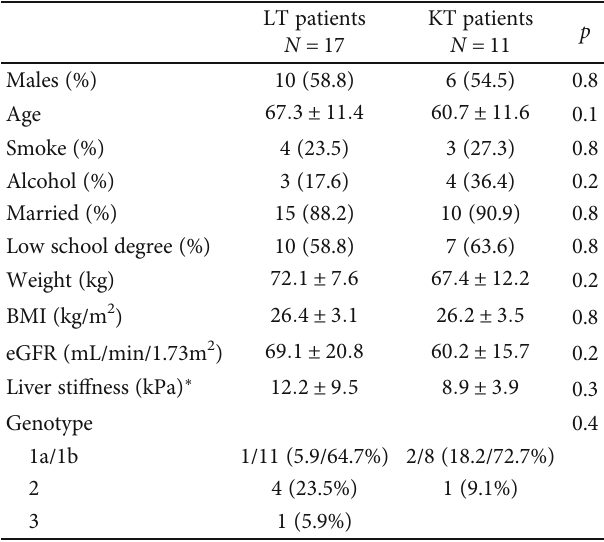
Table 1: Demographic characteristics of LT and KT patients. Data wereexpressedaspercentage(%)or mean ± standard deviation